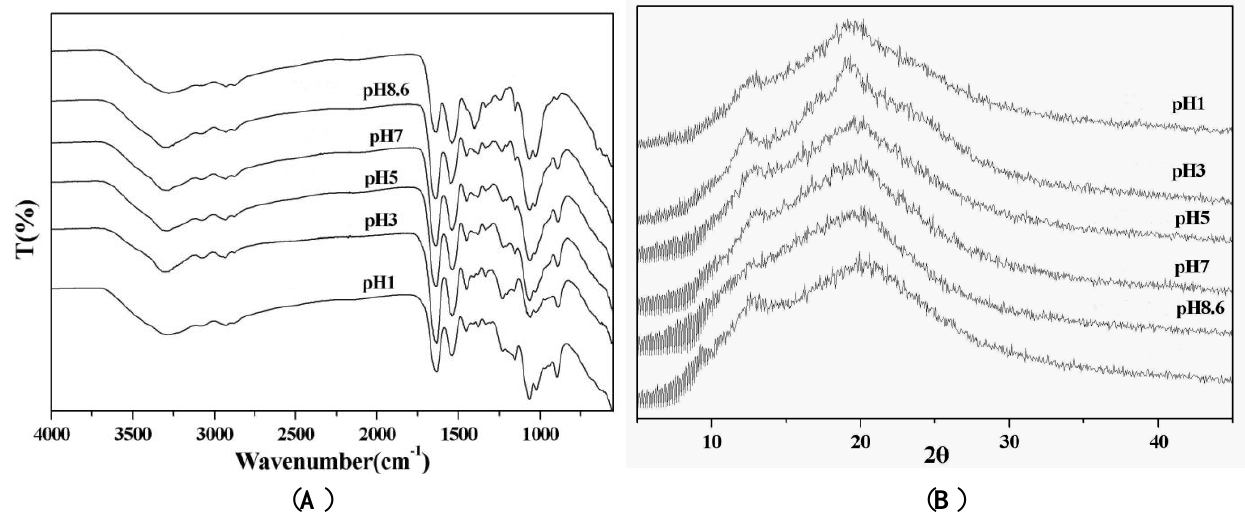
Figure 1. ( A ) FT-IR spectra of TPP-CG composites and ( B ) X-ray diffraction (XRD) patterns of TPP-CG composites prepared at different pH of